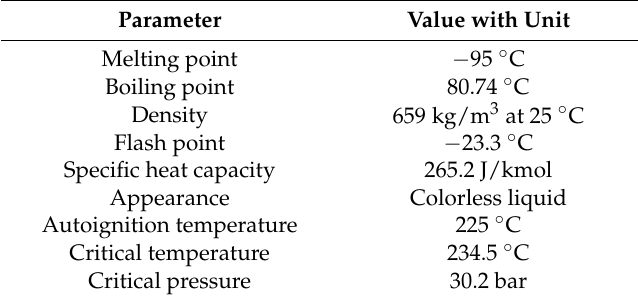
Table 1. Thermal and physical properties of